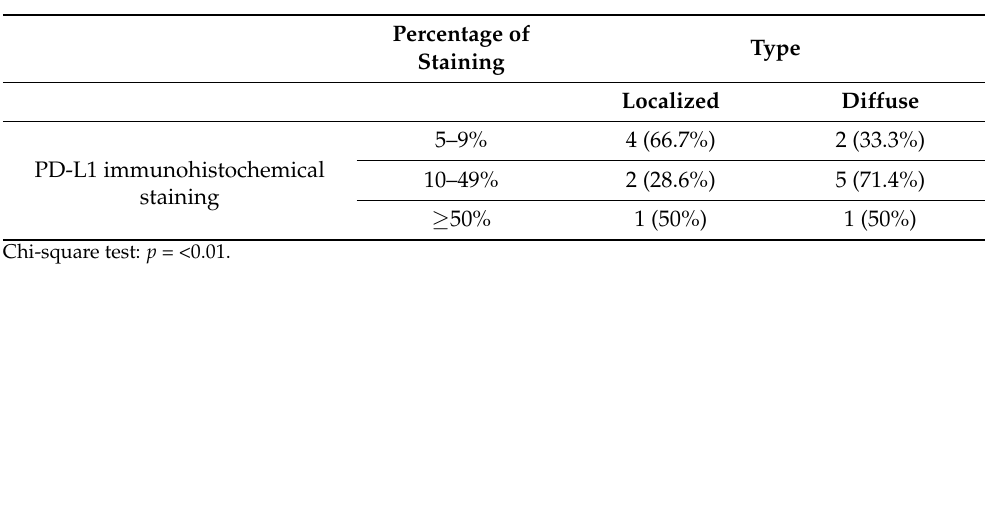
Table 2. Tumor type (localized or diffuse) and PD-L1 staining.